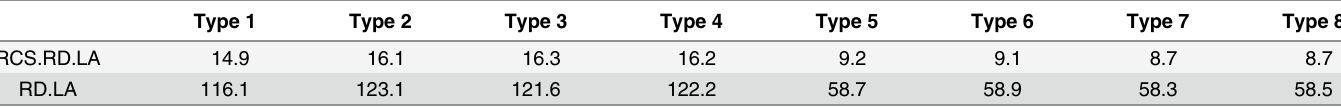
Table 1. Running timings for regression modeling for σ = 1 via glmnet package in R (unit: minute).